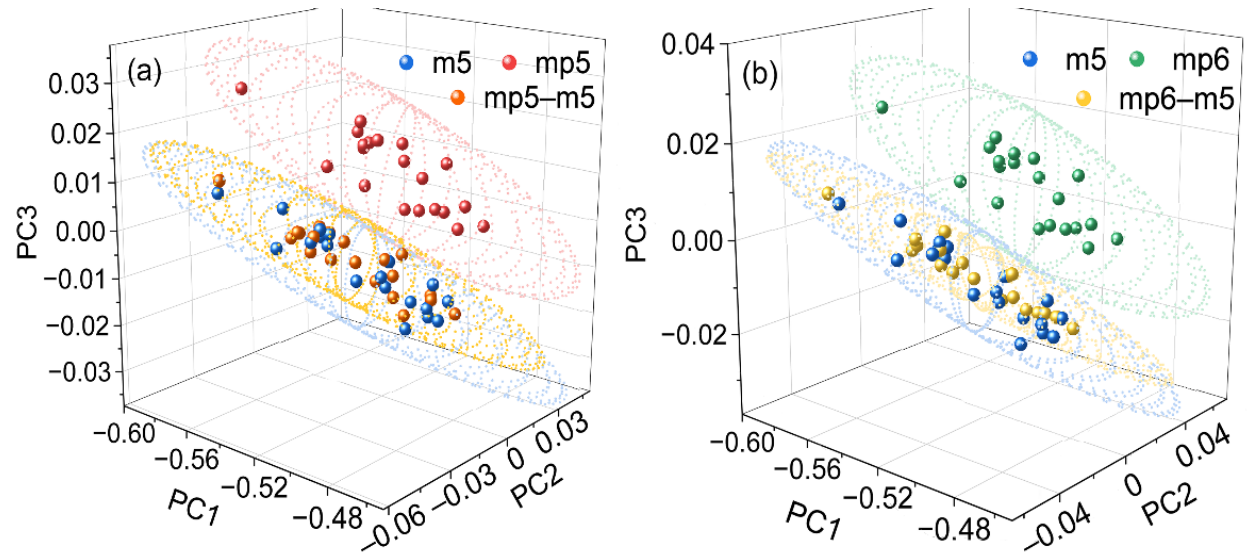
Figure 6. Results of the scores in PC1–PC2–PC3 space for the spectra from m5, mp5, and mp5–m5 ( a ) and spectra from m5, mp6, and mp6–m5 ( b ), respectively. The ellipsoids are determined with the confidence of 95%.